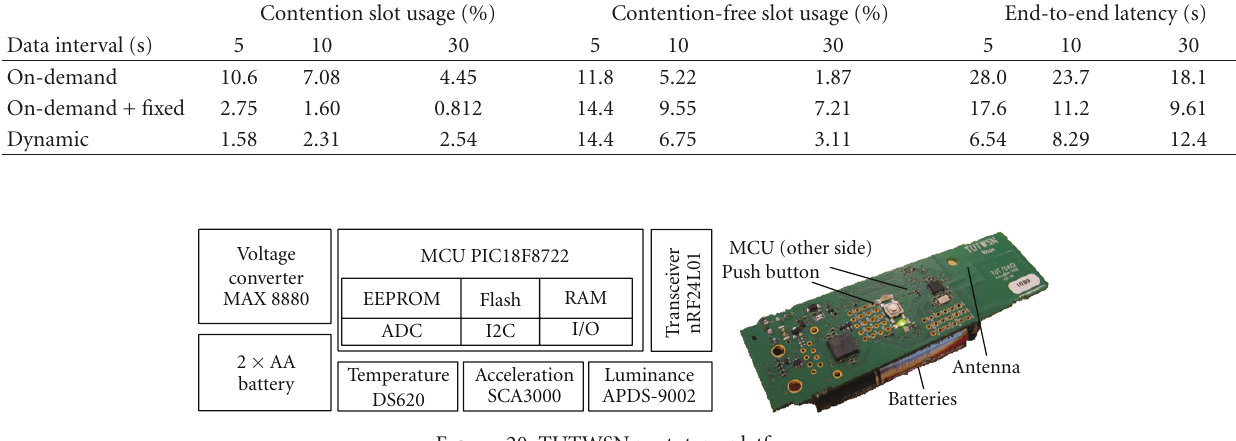
Figure 20: TUTWSN prototype platform.